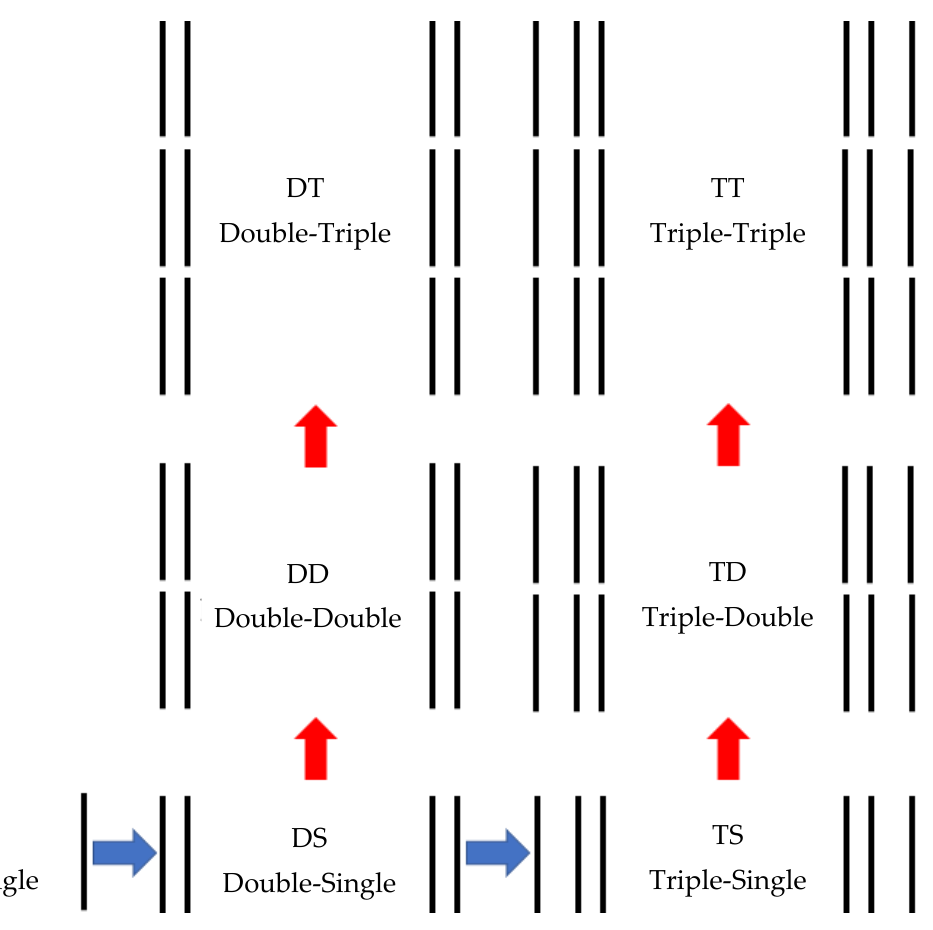
Figure 4. Bailey bridge assemblies, nomenclature, and abbreviations. Table 1. Nomenclature of Bailey bridge parts.